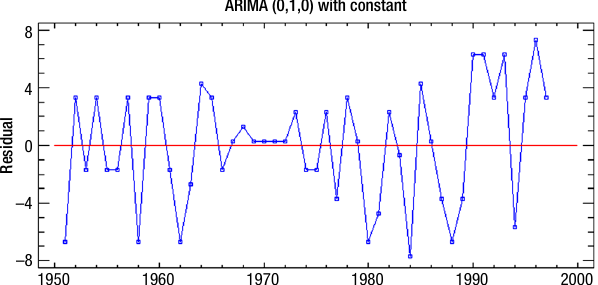
Fig. 15a. Residual plot for adjusted time series of annual Argentinian GDP